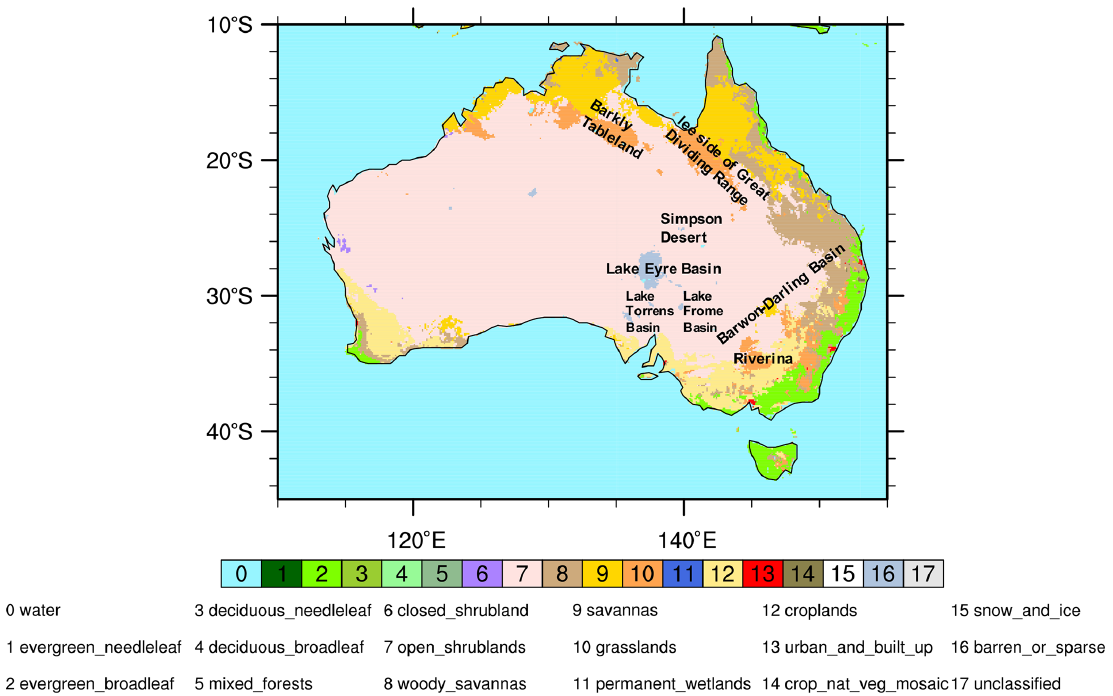
Figure 1. Dominant land cover type across Australia in 2012, marked with key dust source regions. The land cover data is from MODIS, based on the International Geosphere-Biosphere Programme (IGBP) classification scheme (Sulla-Menashe and Friedl, 2018). The land cover fraction of 18 classes is interpolated from 0.05 to 0.1 ◦ .